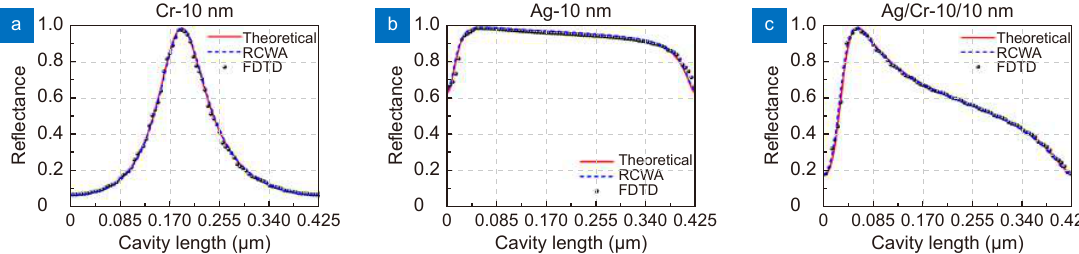
Fig. 2 | Comparison of reflectance verse cavity length between the theoretical results and results obtained by RCWA and FDTD for cases of a suspended film of ( a ) Cr with a thickness of 10 nm, ( b ) Ag with a thickness of 10 nm and ( c ) a stack of Ag/Cr with the thickness of 10/10 nm, and the reflector is a 1 μm thick